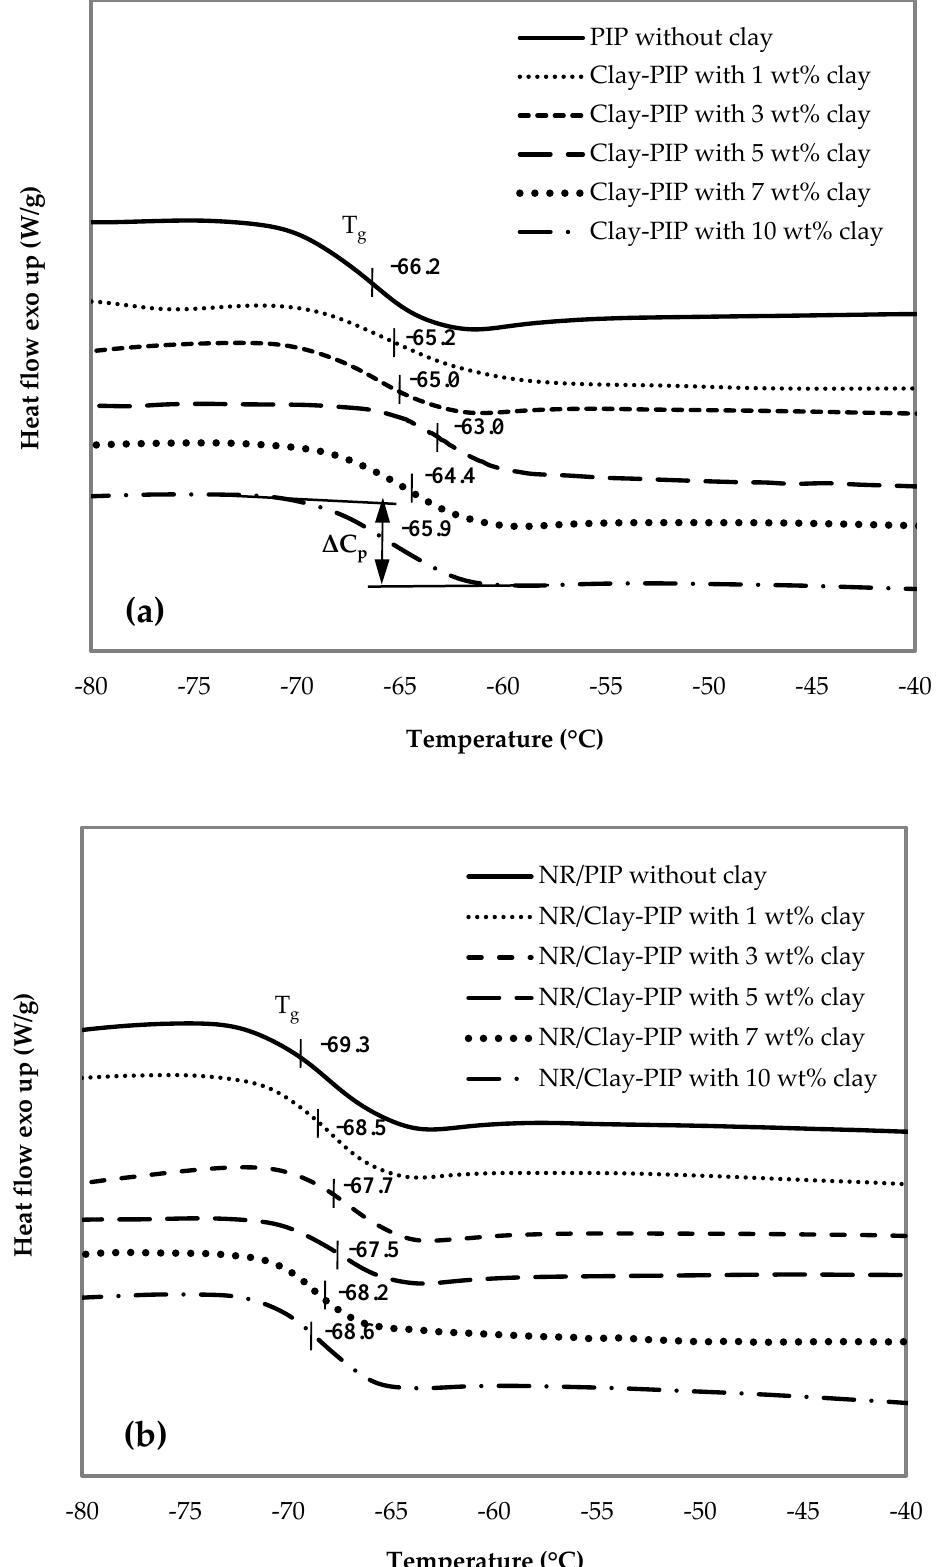
Figure 7. DSC thermograms of the ( a ) Clay-PIP and ( b ) NR / Clay-PIP composites containing various